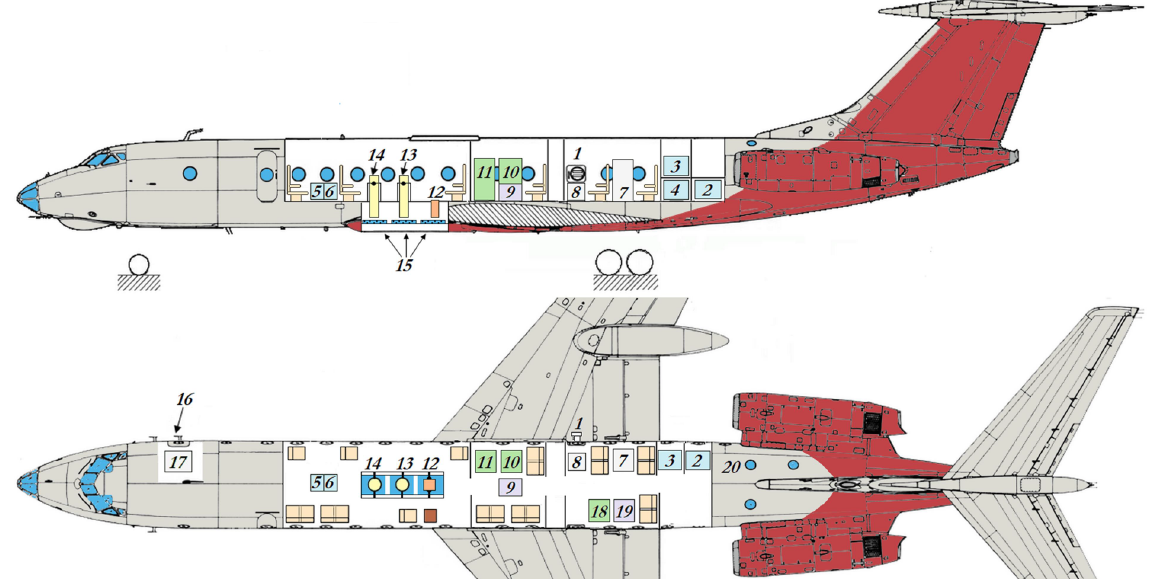
Figure 1. Arrangement of the instrument suite on board the OPTIK TU-134 aircraft laboratory: 1 – ambient air inlets and RH&T probe; 2 – aircraft electrical power distribution unit (28 VDC); 3, 4, 5, 6 – inverters (28 VDC/220 VAC) and UPSs (Delta RT-2K); 7 – aerosol instrument rack: Aethalometer (MDA-02) and photoelectric aerosol nephelometer (FAN-M); 8 – aerosol instrument rack: diffusional particle sizer (DPS), optical particle counter (Grimm 1.109), filter, and bioaerosol sampling suite; 9 – navigation system (CompaNav-5.2 IAO);